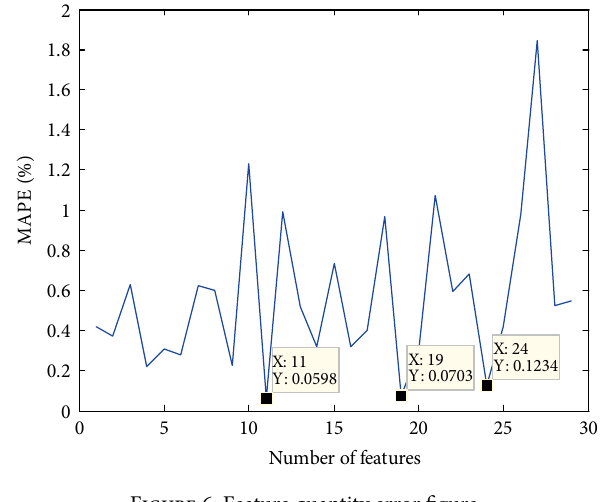
Figure 6: Feature quantity error figure. Table 4: The input feature of IMF6.